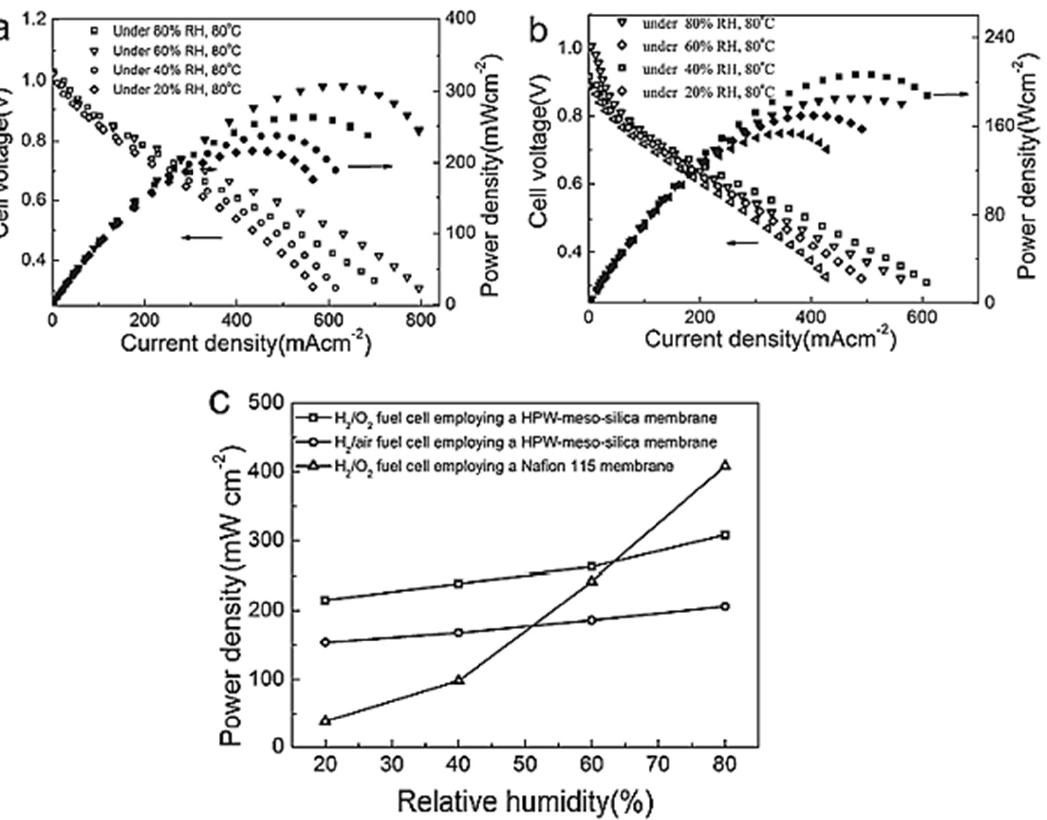
Figure 9. Polarization and power density of single cells developed an 80% HPW-meso-silica nano- composite membrane in ( a ) H 2 /O 2 and ( b ) H 2 /air at 80 °C under various relative humidity (RH) val- ues. ( c ) The plot of the dependence on RH of the maximum power density of cells with 80% HPW- meso-silica and Nafion 115 membranes. Copyright 2011 by American Chemical Society [80].